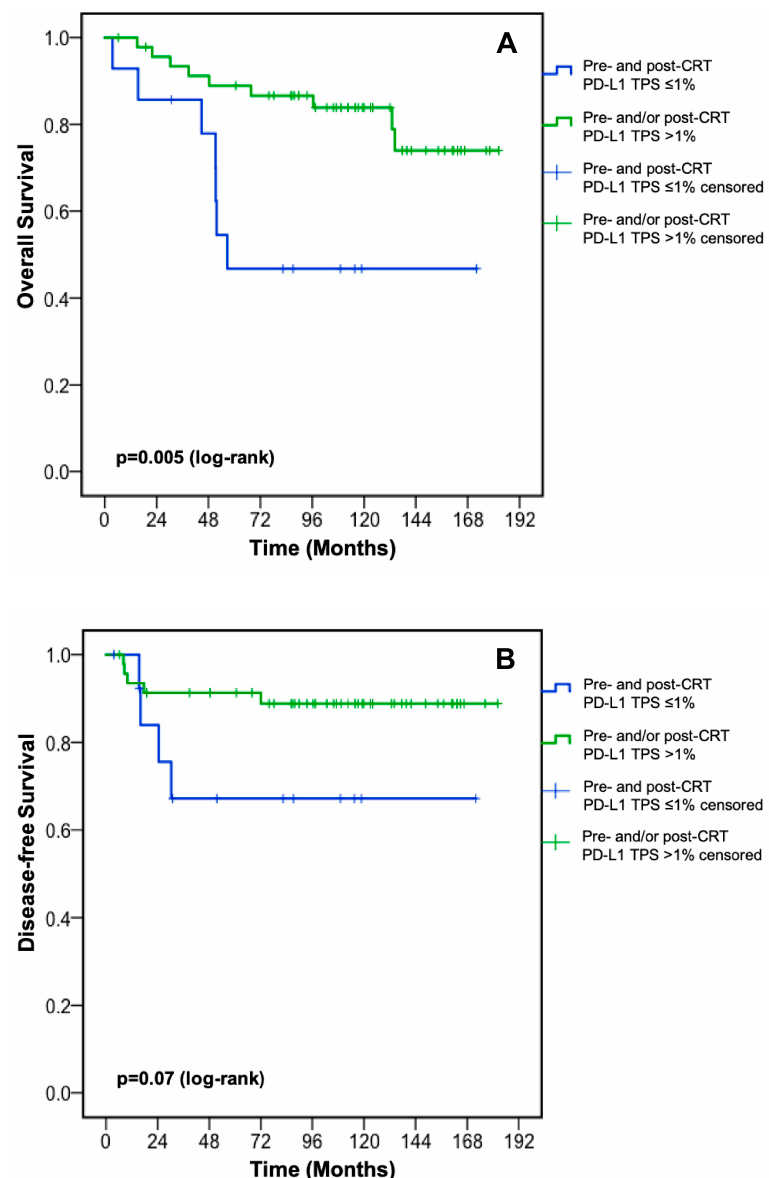
Figure 4. Overall survival (A) and disease-free survival (B) according to PD-L1 TPS changes during neoadjuvant CRT. CRT: chemoradiotherapy; PD-L1: programmed death-ligand 1; TPS: tumor proportion score. The tick marks on the curves represent censored patients.